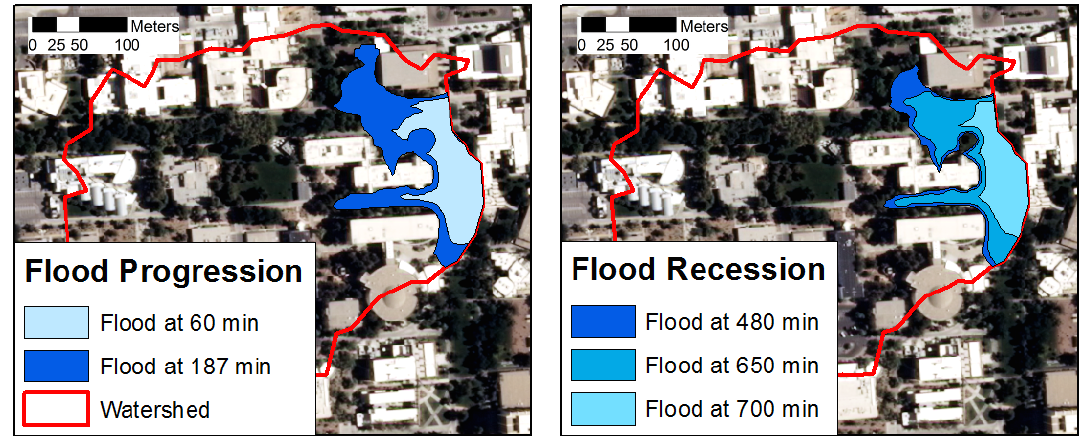
Figure 13. Spatiotemporal map of inundation at East